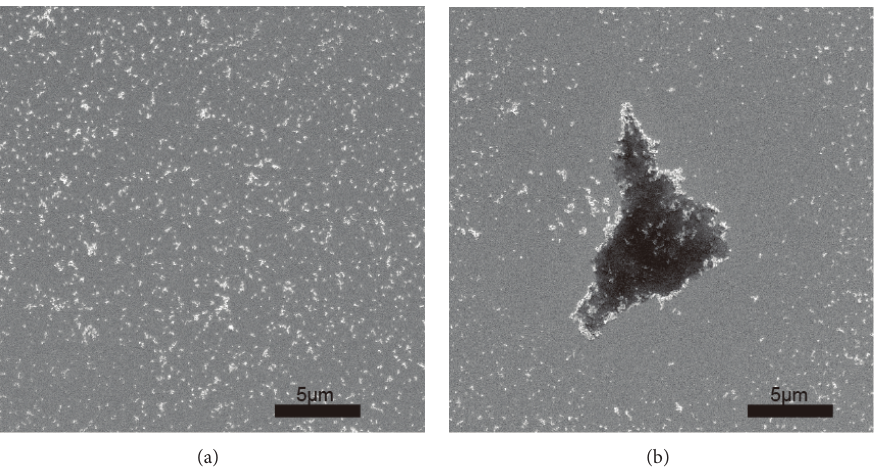
Figure 3: SEM images of spin-casted STFs on Si wafer: (a) 15% silica + 0% GO and (b) 15% silica + 0.2%